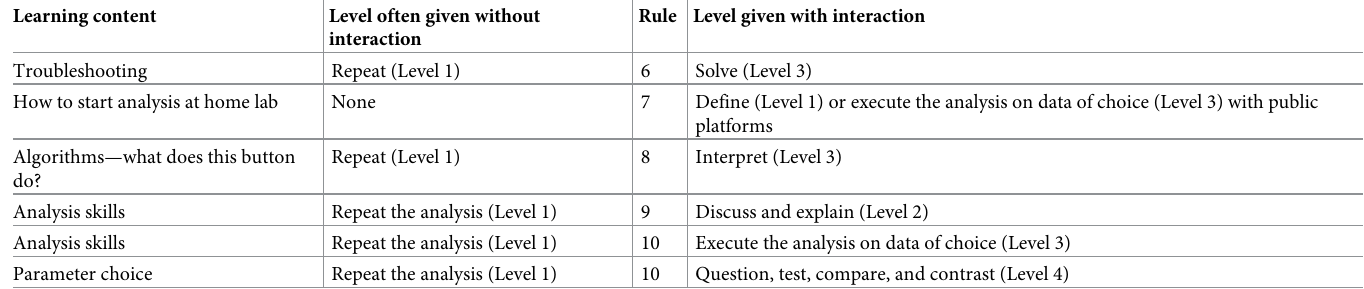
Table 3. Common learning objectives in virtual course environments and how interaction elevates them. Learning